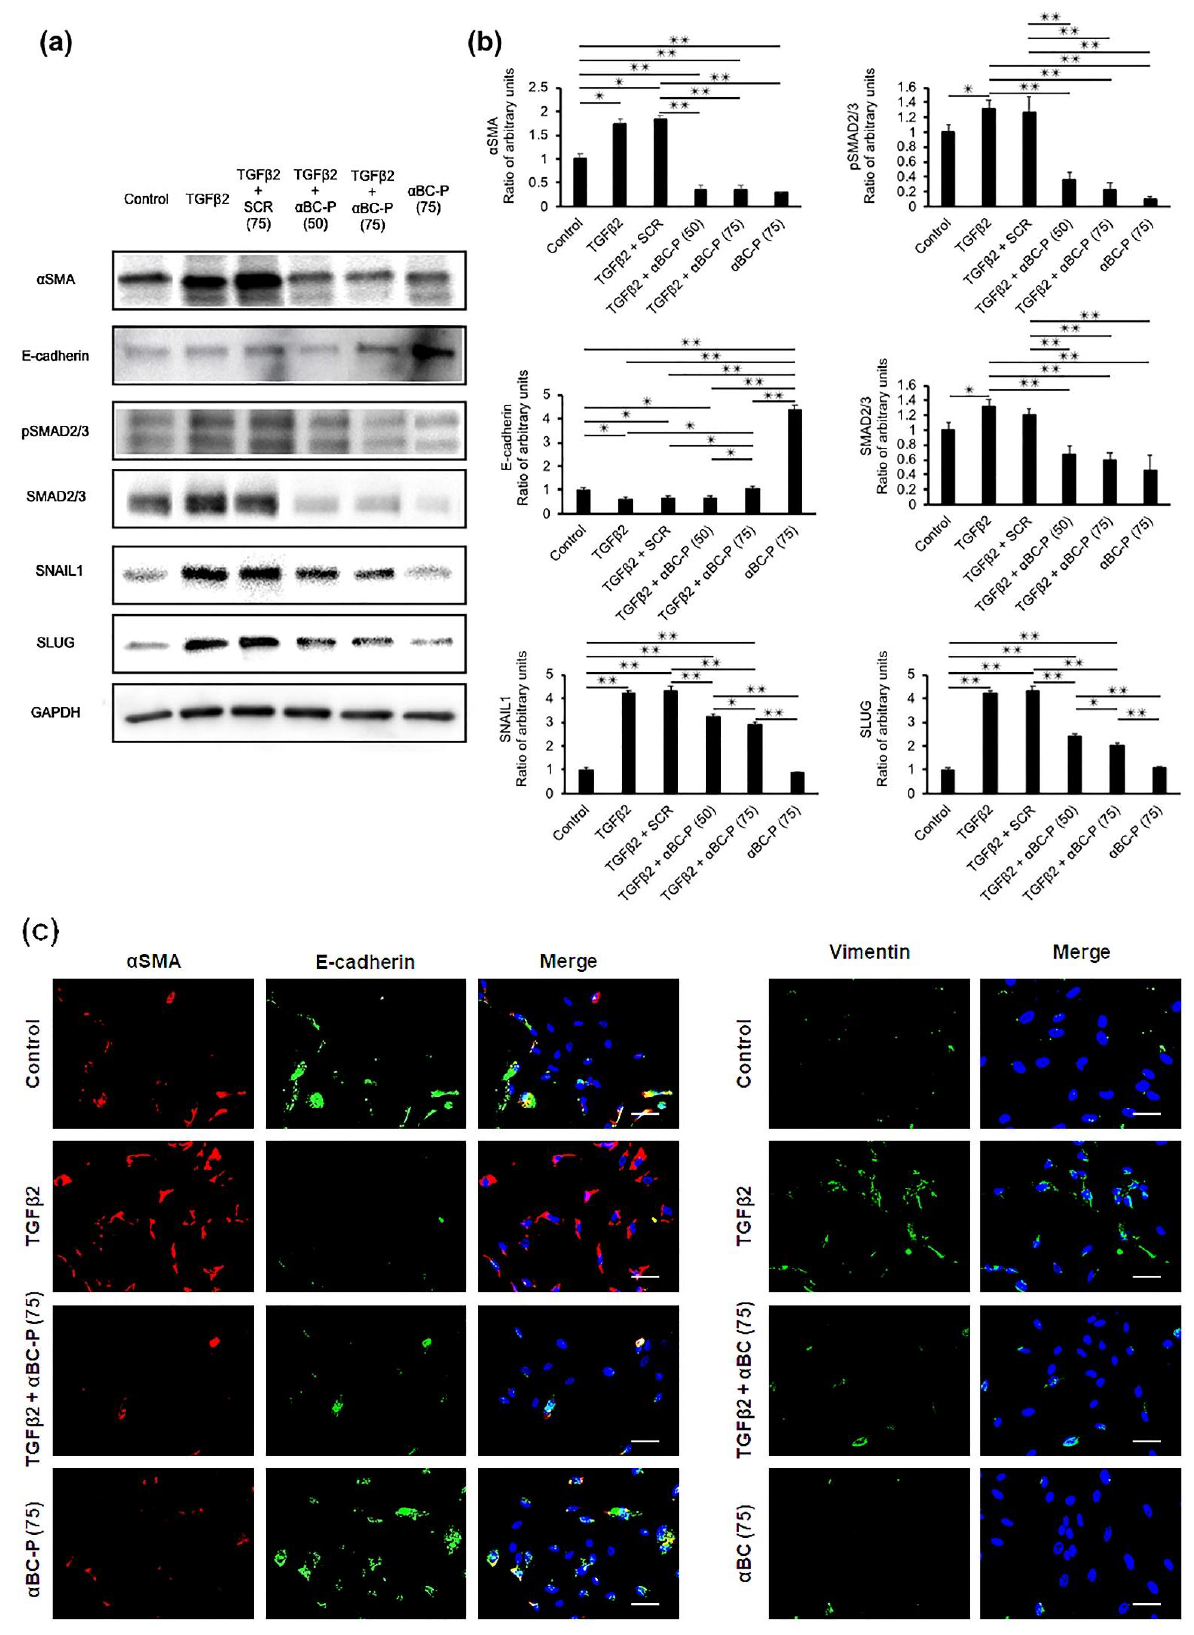
Figure 2. Regulation of EMT- and MET- associated proteins by αBC -P in fetal hRPE cells. ( a , b ) Sub- confluent fetal RPE cells were treated with TGFβ2 (10 ng /mL) alone or/with Scr. (75 μg /mL) or/with αBC - P (50 and 75 μg /mL) or αBC - P (75 μg /mL) alone for 48 h. Protein expression was measured by Western blot analysis. EMT- associated proteins (αSMA, pSMAD2/3, SMAD2/3) and transcription proteins SNAIL and SLUG increased significantly with TGFβ2 stimulation, and αBC -P markedly inhibited their expression. Moreover, MET-associated protein (E-cadherin) decreased significantly with TGFβ2 stimulation, and αBC -P markedly increased their expression. ( c ) hRPE cells were cul- tured in 4 well chamber slides. The cells were treated with TGFβ2 (10 ng /mL) or/and αBC -P (75) for 24 h at 37 °C. After washing, cells were imaged with fluorescence microscope. Scale bar: 50 µm, ( Left images) Red: αSMA , Green: E-cadherin, Blue: DAPI. ( Right image) Red: αSMA, Green: E -cad- herin, Blue: DAPI. Scr.: Scrambled peptide, αBC - P: αB crystallin -chaperone peptide. Values are means ± SEM. * p < 0.05, ** p < 0.01. n = 3. 3.3. α BC-ELP Treatment Inhibited Mitochondrial ROS Production in hRPE Cells Exposed to TGFβ2 Reactive oxygen species (ROS) are thought to play a key role in the common fibrotic pathway [38]. We therefore investigated whether TGFβ -2 causes oxidative stress in hRPE cells. TGFβ2 treatment for 24 -h-induced mitochondrial superoxide production in hRPE cells. On the other hand, co- treatment with the protein αBC minipeptide fusion protein (αBC - ELP) inhibited the generation of ROS caused by TGFβ -2 (Figure 3). No appreciable cell death was observed in RPE cells treated with varying doses of TGFβ -2 (5 – 20 ng/mL) for 48 h (data not shown).